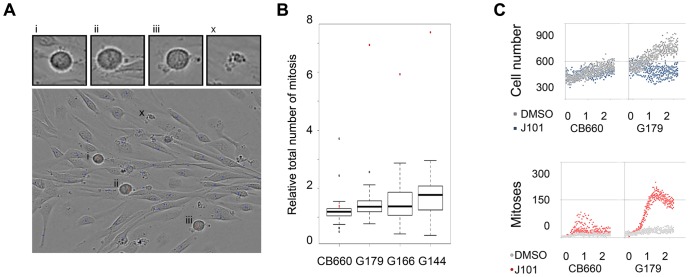
JNJ-10198402 induces mitotic arrest in GNS cells but not in normal NS cells.(A) Segmentation of phase contrast images with high-content analysis software (CellProfiler & CellProfiler Analyst). Objects were assigned into different classes/bins. Interphase cells (blue) and mitoses (red; ‘i–iii’). Erroneously segmented debris or dead cells (green; ‘x’) are isolated and discarded from event counts. (B) Relative number of mitoses scored within 48 h from the start of the experiment for each line and all 160 inhibitors. (C) Kinetics of change in total cell number and mitosis for G179. J101 significantly increased the number of mitoses in G179, but not CB660, without parallel increases in cell number (top panel; blue dots), whereas cells with mitotic morphology increased dramatically during the first 1–2 days (bottom panel; red dots).